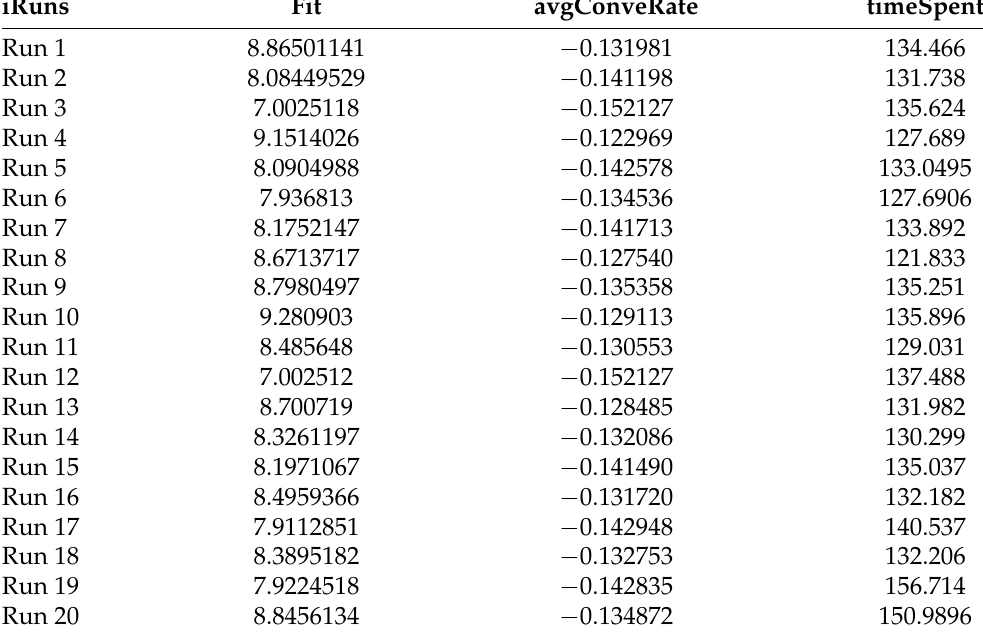
Fig. 6: CBCC-RDG3, 5 10 4 func. Fig. 7: CBCC-RDG3, 10 5 func. eval- Figure 7. CBCC-RDG3, 10 5 func. evaluations: 135.64 s optimization value = 9.6103. × Table 1. The table of obtained solutions for CBCC-RDG3